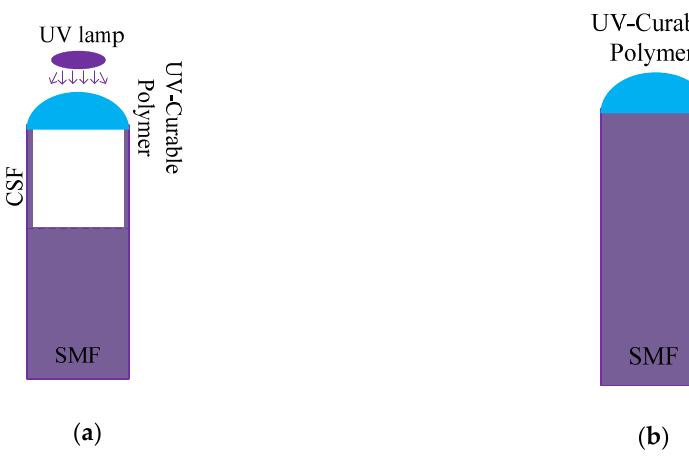
Figure 20. The description of the structures: ( a ) The lensed fiber consists of SMF, CSF, and UV-curable polymer [90]; ( b ) Sensor consists of SMF and UV-curable polymer [91].